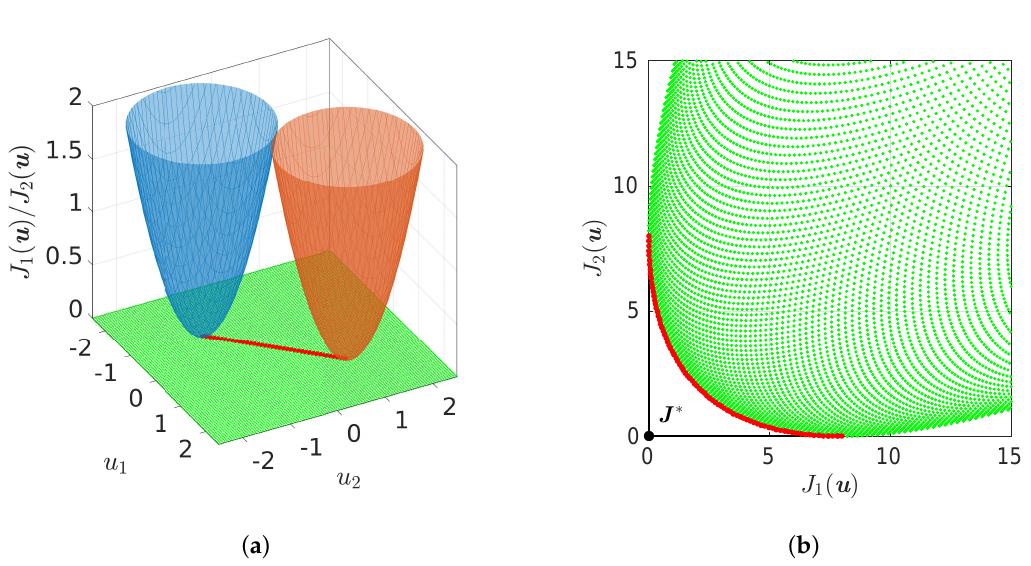
Figure 1. The red lines are the Pareto set ( a ) and Pareto front ( b ) of an exemplary multiobjective optimization problem (two paraboloids) of the form min u ∈ R J ( u ) , J : R 2 → R 2 . The point J ∗ = ( 0,0 ) (cid:62) is called the utopian